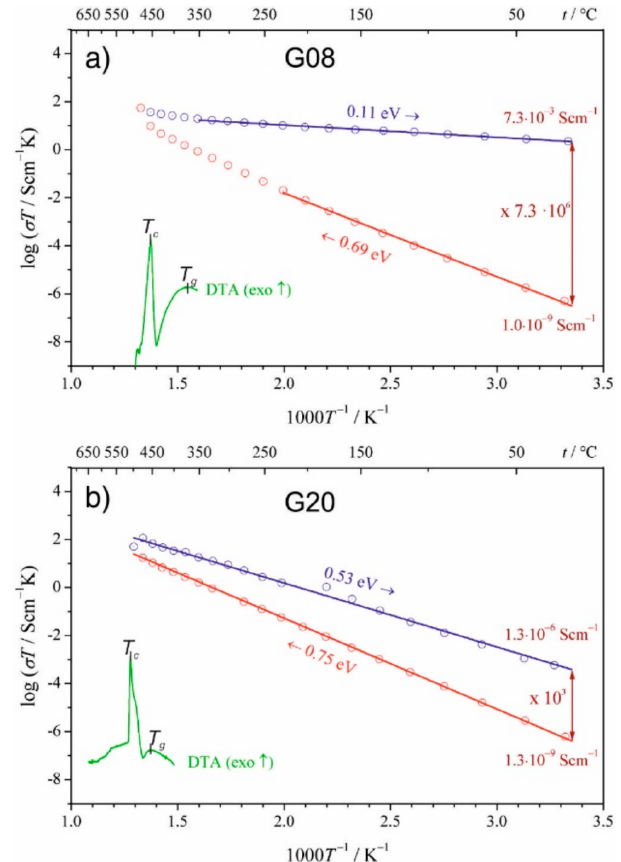
Figure 6. Arrhenius plots of the electrical conductivity for olivine-like materials: ( a ) LiFe 0.80 V 0.08 PO 4 (G08) and ( b ) LiFe 0.50 V 0.20 PO 4 (G20), before (heating ramps–red) and after nanocrystallization (cooling ramps–blue). The respective DTA traces recorded at a rate of 1 ◦ C/min are inserted for comparison. (Reproduced with permission from ref. [45]. Copyright 2015,